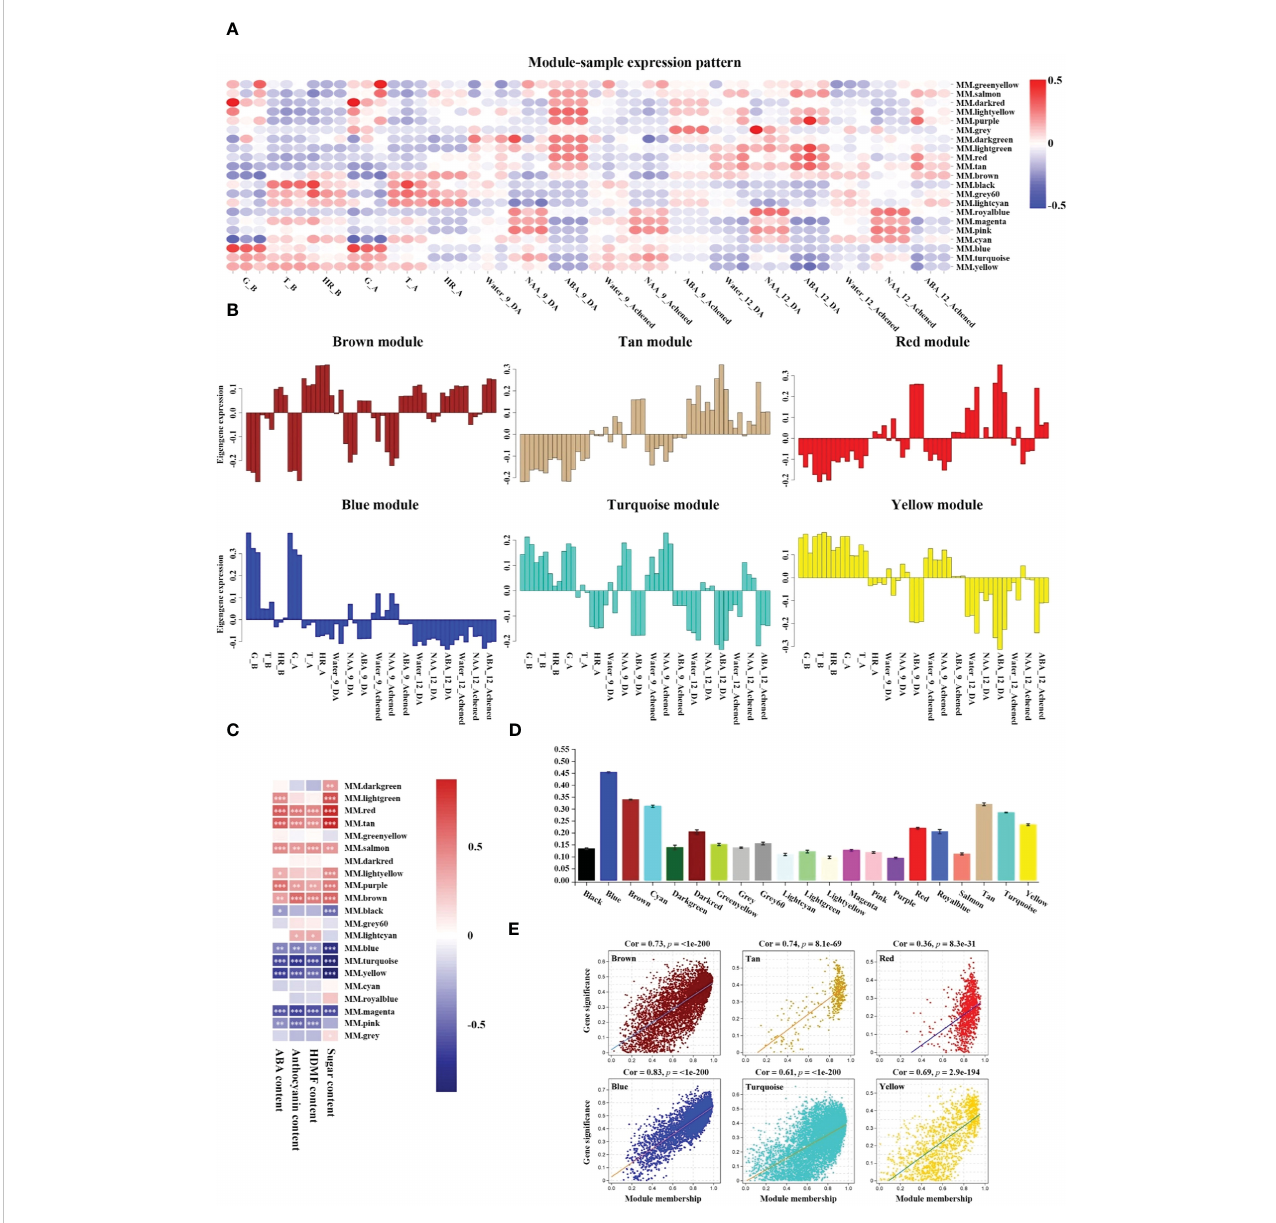
FIGURE 2 Screening positive and negative modules relevant to receptacle ripening. (A) Heatmap analysis of module expression pattern in samples based on gene expression pro fi les. The red and blue colors denote up- and down-regulation of gene expressions in the samples, respectively. (B) Histograms of expression patterns of six modules in each sample. (C) The Pearson correlation between expression pro fi les of genes in modules and ABA, anthocyanin, HDMF, and sugar contents, respectively. According to Student ’ s paired t-test, white ‘ * ’ , ‘ ** ’ , and ‘ *** ’ in the heatmap represent P < 0.05, P < 0.01, and P < 0.001, respectively. (D) The mean of the Pearson correlation between the expression pro fi les of genes in each module and physiological indices. (E) Analysis of correlation between gene signi fi cance, the correlation between each isoform and ABA level, and module membership, the correlation between expressional pro fi le of each isoform and module. P values were analyzed using a Student ’ s paired t